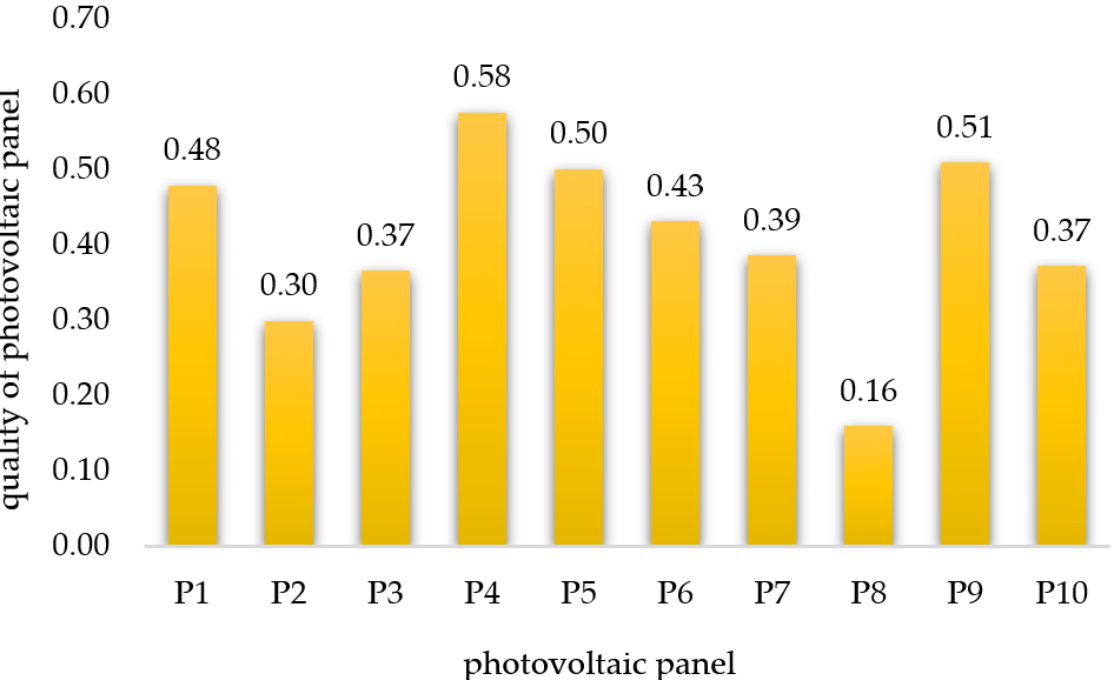
Figure 7. Ranking of photovoltaic panels quality level.